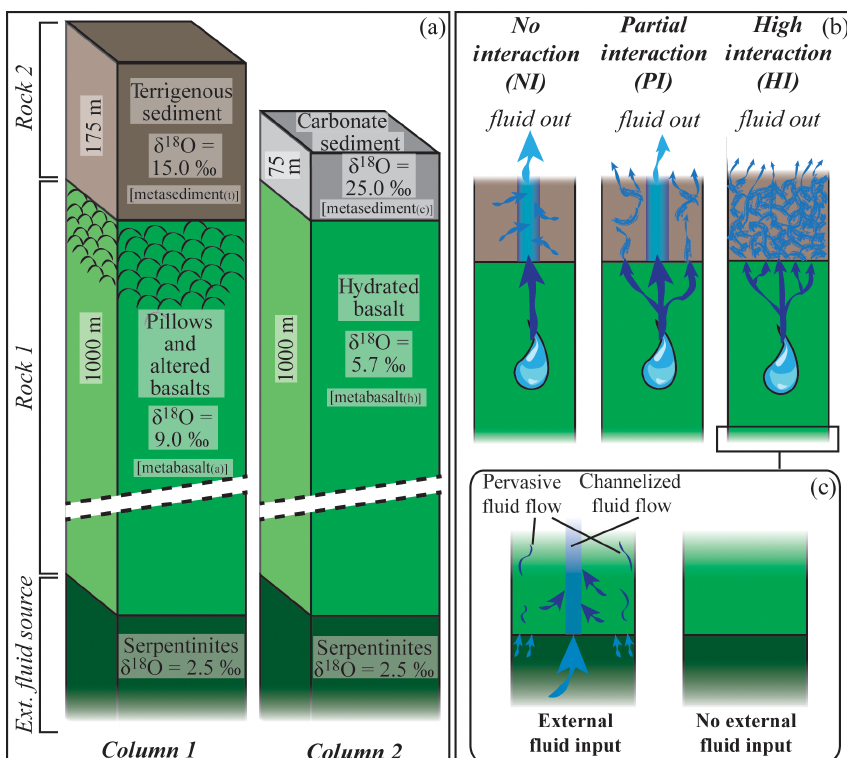
Figure 1. Schematic geometry of the subduction models discussed in the text. The rock column is composed of two rock types (Rock 1 and Rock 2) that can be infiltrated by an external fluid deriving from a third layer located beneath them. (a) Example columns used in the calculation along the P – T path shown in Fig. 2 to produce the results presented in Figs. 3–7. See text for details. (b) Schematic representation of the three interaction cases discussed in the text. No-interaction case (NI): the fluid released by the metabasalt does not interact with the metasediment. The fluid leaving the system is a mixture of metabasalt-derived and metasediment-derived fluids. Partial- interaction case (PI): 50% of the metabasalt-derived fluid does not interact with the metasediment, and 50% of it equilibrates with the metasediment. The final fluid released by the system is the mixture between the unmodified metabasalt-derived fluid and the fluid deriving from the metasediment after it equilibrates with 50% of the metabasalt-derived fluid. High-interaction case (HI): all the fluid released by the metabasalt equilibrates with the metasediment. The fluid leaving the system exits the metasediment. (c) Possible scenario at the base of the column. As a consequence of serpentine breakdown, serpentinite-derived fluids may infiltrate the metabasalt, exchange with it and affect the fluid infiltrating the